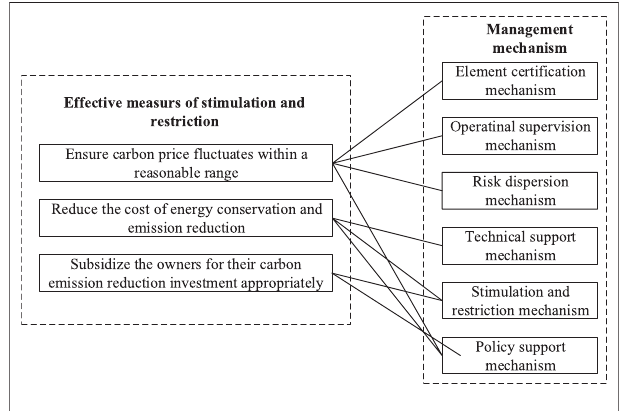
FIGURE 8 | Management mechanism to stimulate public building owners to participate in carbon emissions permit trading.